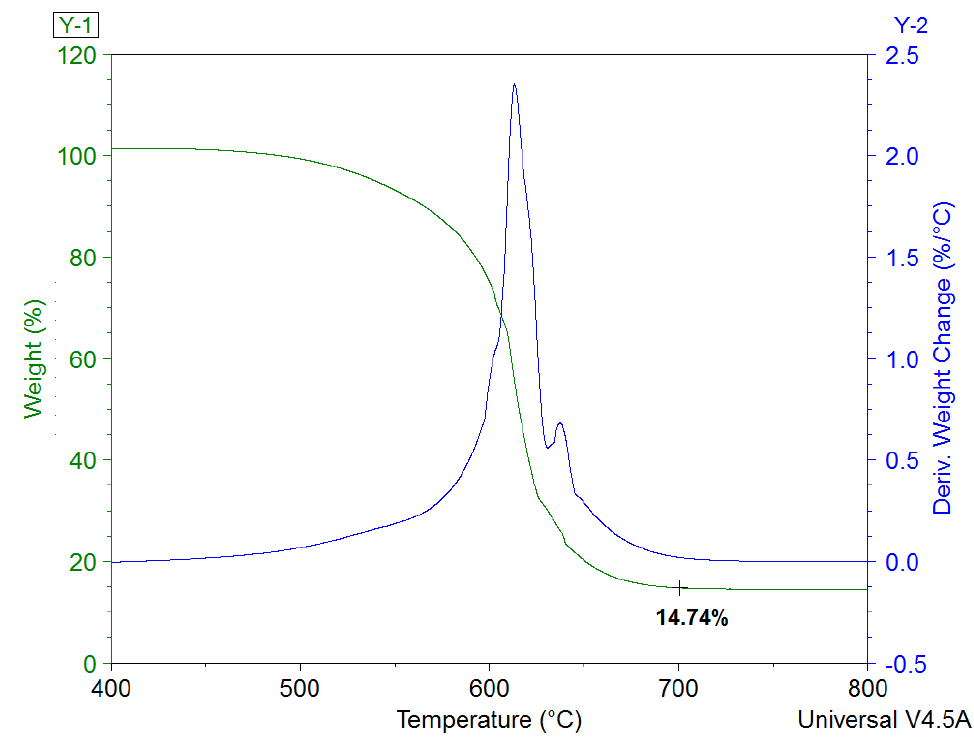
Figure 2. Thermogravimetric analysis of CNTs.